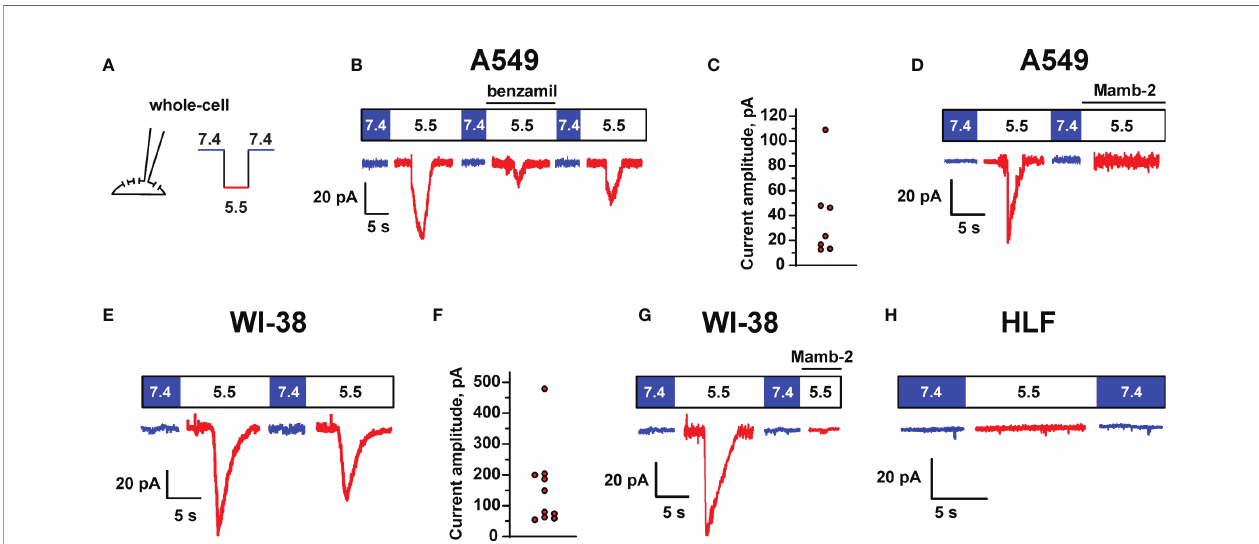
FIGURE 5 | ASIC channel activity in A549, WI-38, and HLF cells. (A) Whole-cell con fi guration of the patch clamp technique and protocol of experiments. Membrane voltage was clamped at – 50 mV in all patches. (B) Representative traces showing ASIC1a-like currents activated by a rapid drop of extracellular pH from 7.4 to 5.5, the currents were reversibly inhibited by 10 m M benzamil (derivative of amiloride). (C) Distribution of transient peak amplitudes at pH 5.5 elicited ASIC1a-like currents in A549 cells. (D) The effect of mambalgin-2 on ASIC1a-like currents in A549 cells. (E) ASIC1a-like currents in WI-38 cells. (F) Distribution of transient peak amplitudes in WI-38 cells at pH 5.5 elicited ASIC1a-like currents. (G) The effect of mambalgin-2 on ASIC1a-like currents in WI-38 cells. (H) An absence of acidi fi cation-evoked currents in HLF